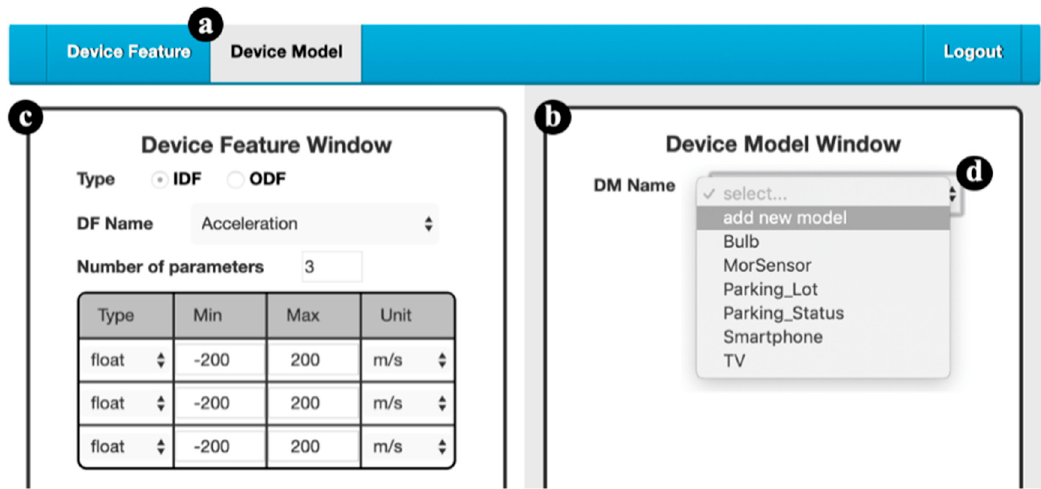
Figure A5. Device Model window.